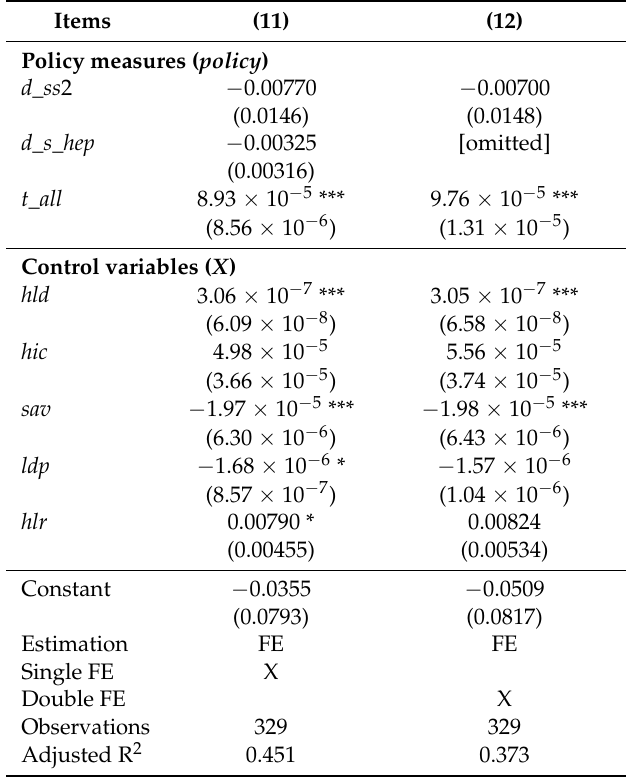
Table 7. Results of the panel data analyses for Case